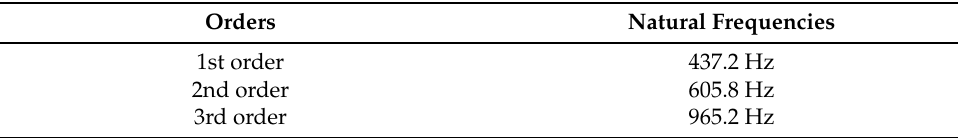
Table 5. Natural frequencies of gearbox housing.